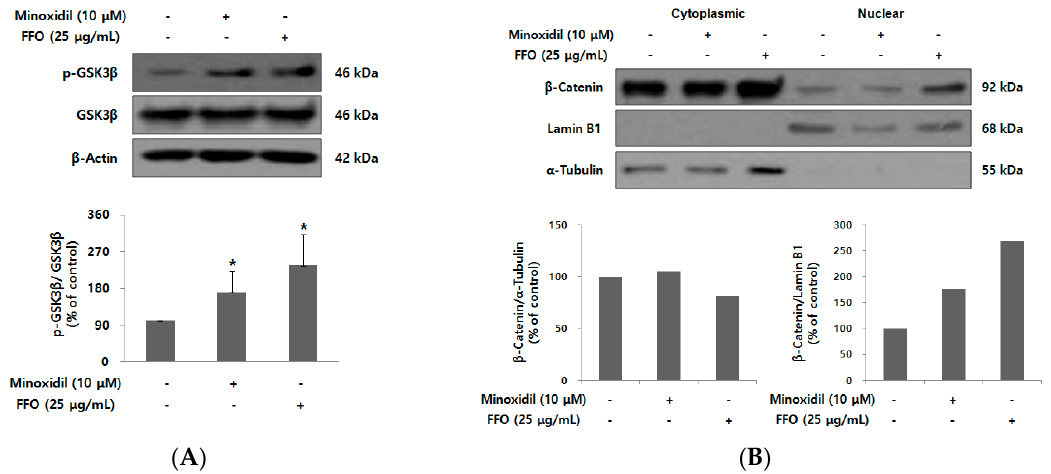
Figure 5. The effect of FFO extract on the level of Wnt/ β‐ catenin signaling proteins. ( A ) DPCs were stimulated with minoxidil (10 μ M) or FFO extract (25 μ g/mL) for 18 h. The levels of phospho ‐ GSK3 β and GSK3 β were determined using an immunoblot. The graph represents the quantitative level of the proteins. The data are presented as the mean ± SD from three independent experiments. * p < 0.05 vs. vehicle-treated control. ( B ) DPCs were stimulated with minoxidil (10 µ M) or FFO extract (25 µ g/mL) for 56 h. Cytoplasmic and nuclear fractions were prepared as described in Section 4. The protein level of β -catenin was determined using an immunoblot. α -Tubulin and lamin B1 were used to confirm the same loading of cytoplasmic and nuclear proteins. The graph represents the quantitative level of the proteins.